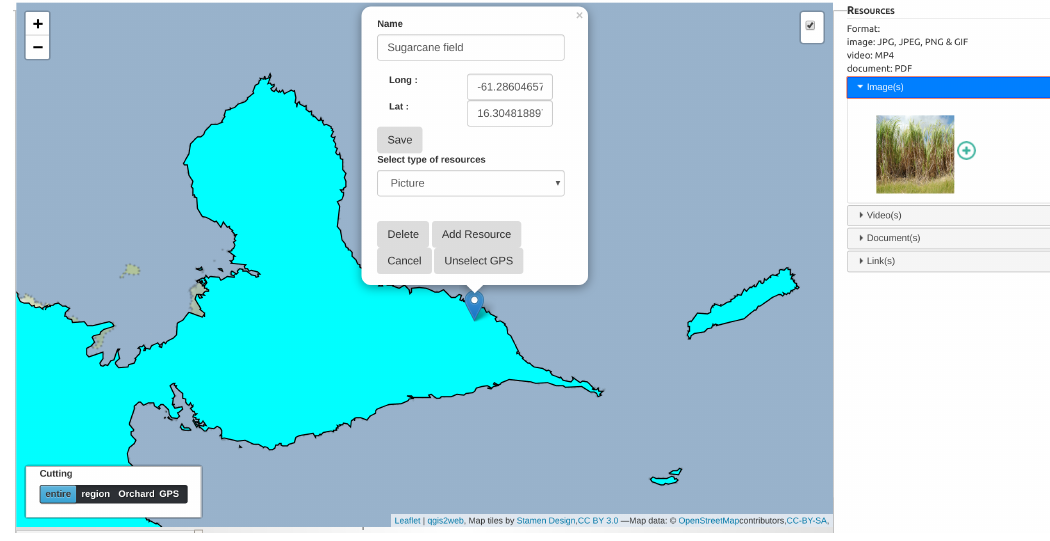
Figure 8. DKP: georeferencing a